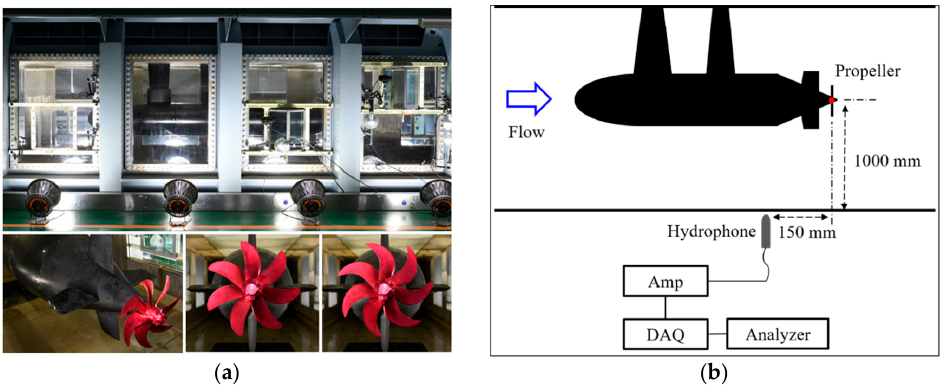
Figure 5. Experimental setup: ( a ) photograph of scalded Suboff submarine with two kinds of propellers installed in the test section of the large cavitation tunnel (LCT) in Korea Research Institute of Ships and Ocean Engineering (KRISO); ( b ) schematic diagram for noise measurement.